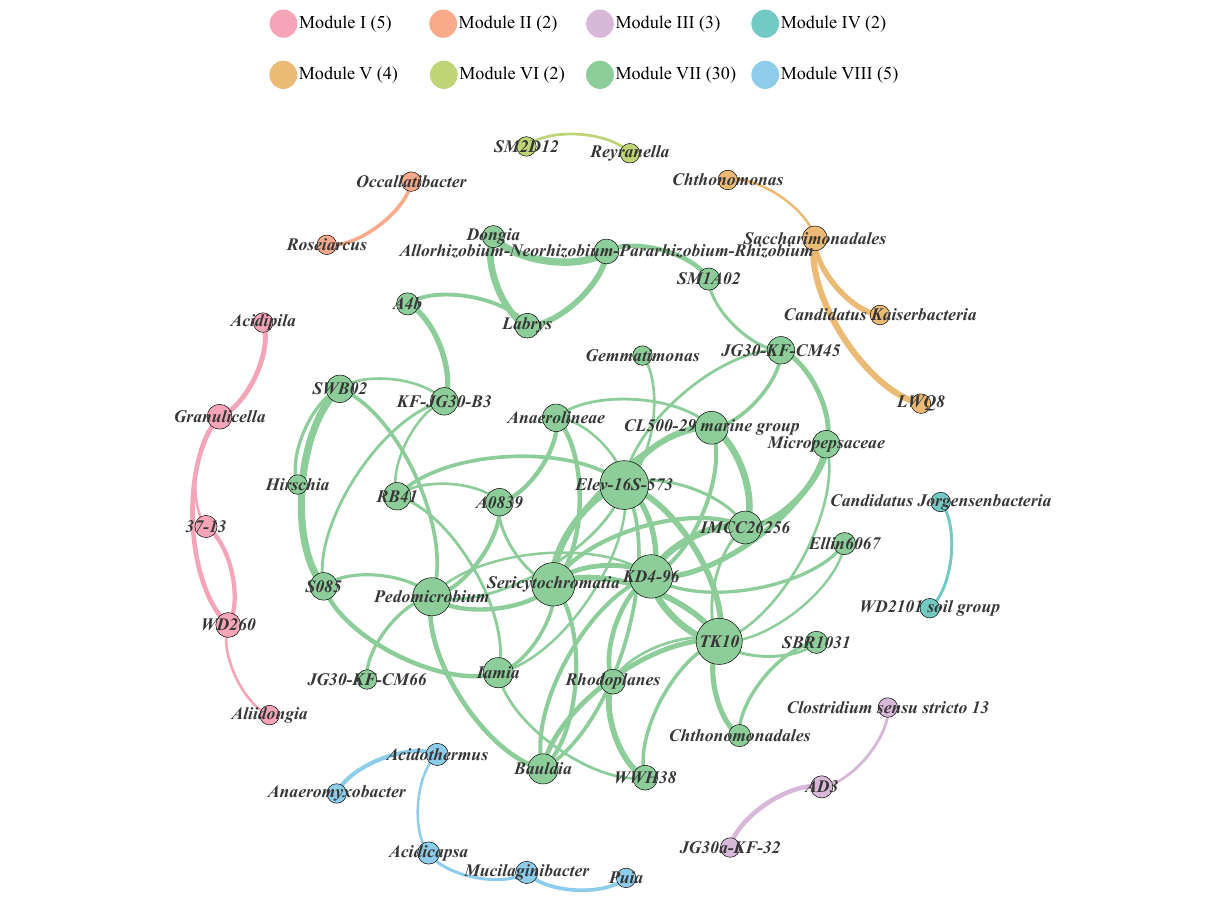
FIGURE 3 | Network analysis revealing co-occurrence patterns of soil bacterial genera at Mt. Shergyla. The nodes were colored according to the modules of bacterial genera. A connection represents a strong (Spearman’s correlation coefficient > 0.8) and significant ( P < 0.05) correlation. The size of each of nodes is proportional to the number of connections, i.e.,